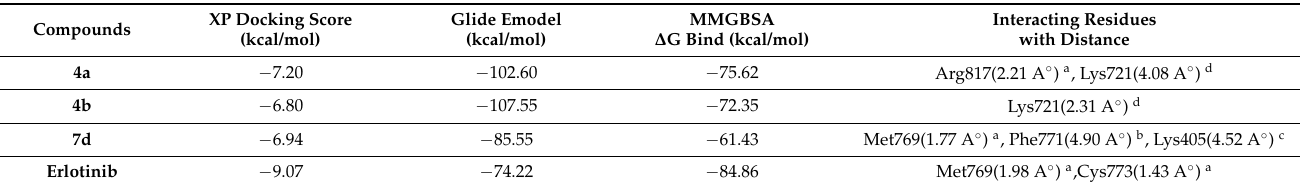
Table 6. Glide XP dock score and binding free energy of promising compounds with human EGFR (PDB ID: 1M17)